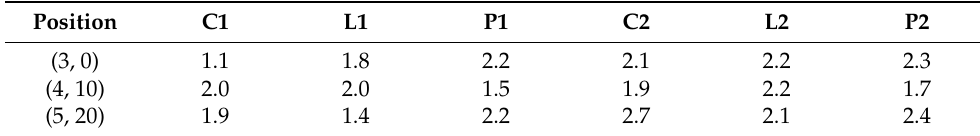
Table 1. CNR values.